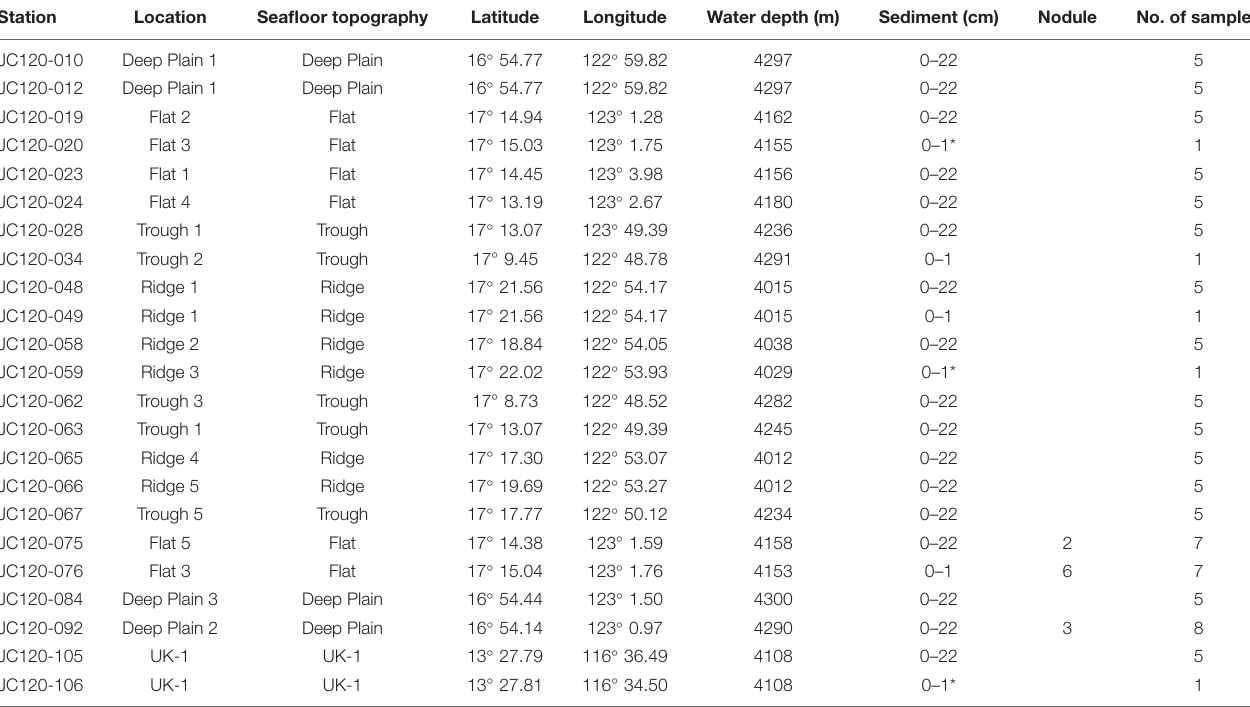
TABLE 1 | Sampling site locations of megacore deployments in APEI-6 SW and UK-1 (UK Seabed Resources Limited eastern contract area) that were collected during cruise JC120 with location and depths shown for each sample taken. Station Location Seafloor topography Latitude Longitude Water depth (m) Sediment (cm) Nodule No. of